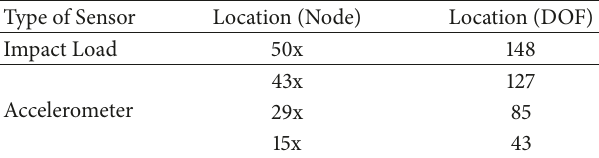
Table 10: Location of impact load and accelerometer.